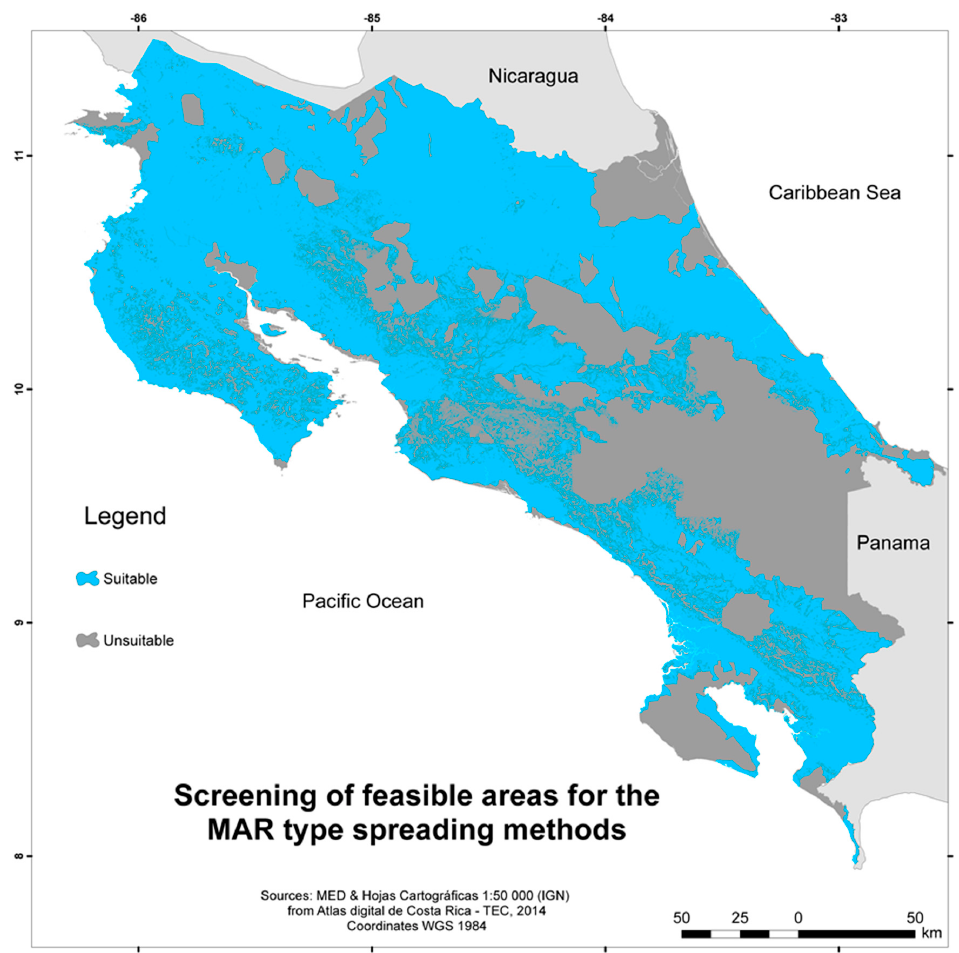
Figure 6. Screening suitable sites for SM in Costa Rica based on the terrain slope lower than 40% and protected areas, beaches, and wetlands.